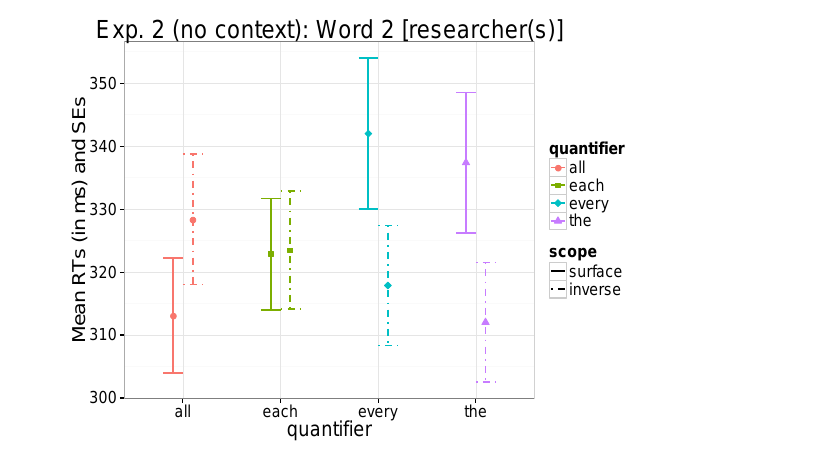
Figure 9 Mean RTs and SEs for Word 2 in Experiment 2 (no